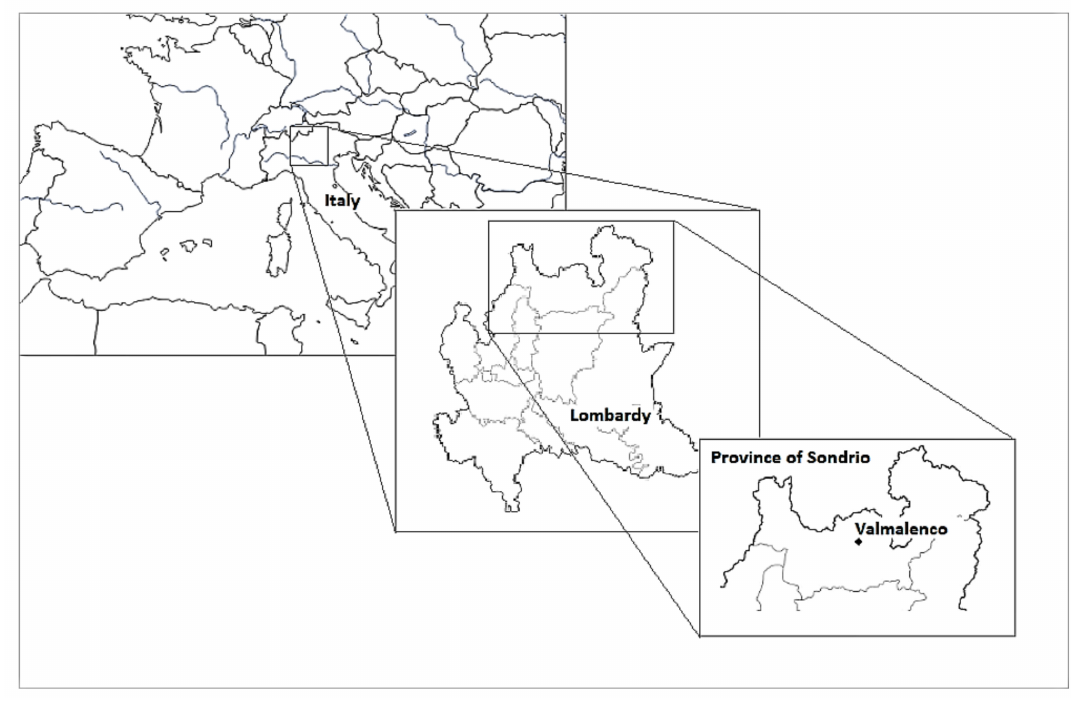
Figure 1. Geographical position of Valmalenco (SO,